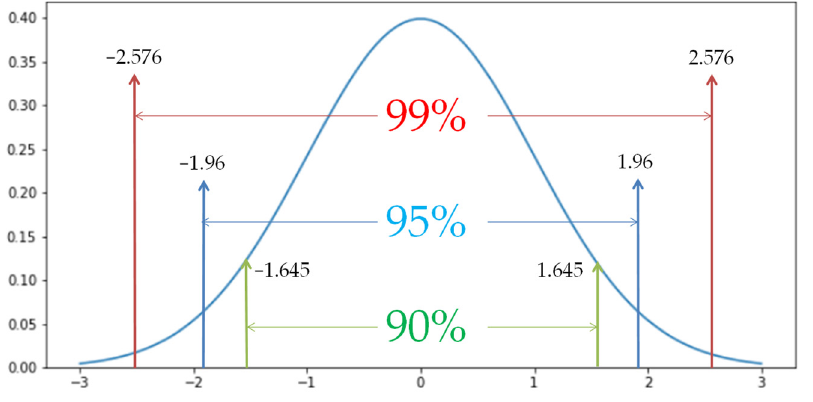
Figure 4. N (0,1) 90%, 95%, 99% cutoff values. Data source: Heumann and Schomaker [45]. CI refers to a researcher’s confidence in inferring population according to the result; 95% CL or 99% CL is generally adopted in human science [46]. As shown in Equations (3) and (4), CL 95% is commonly used, but when calculating CI under other CL, e.g.,